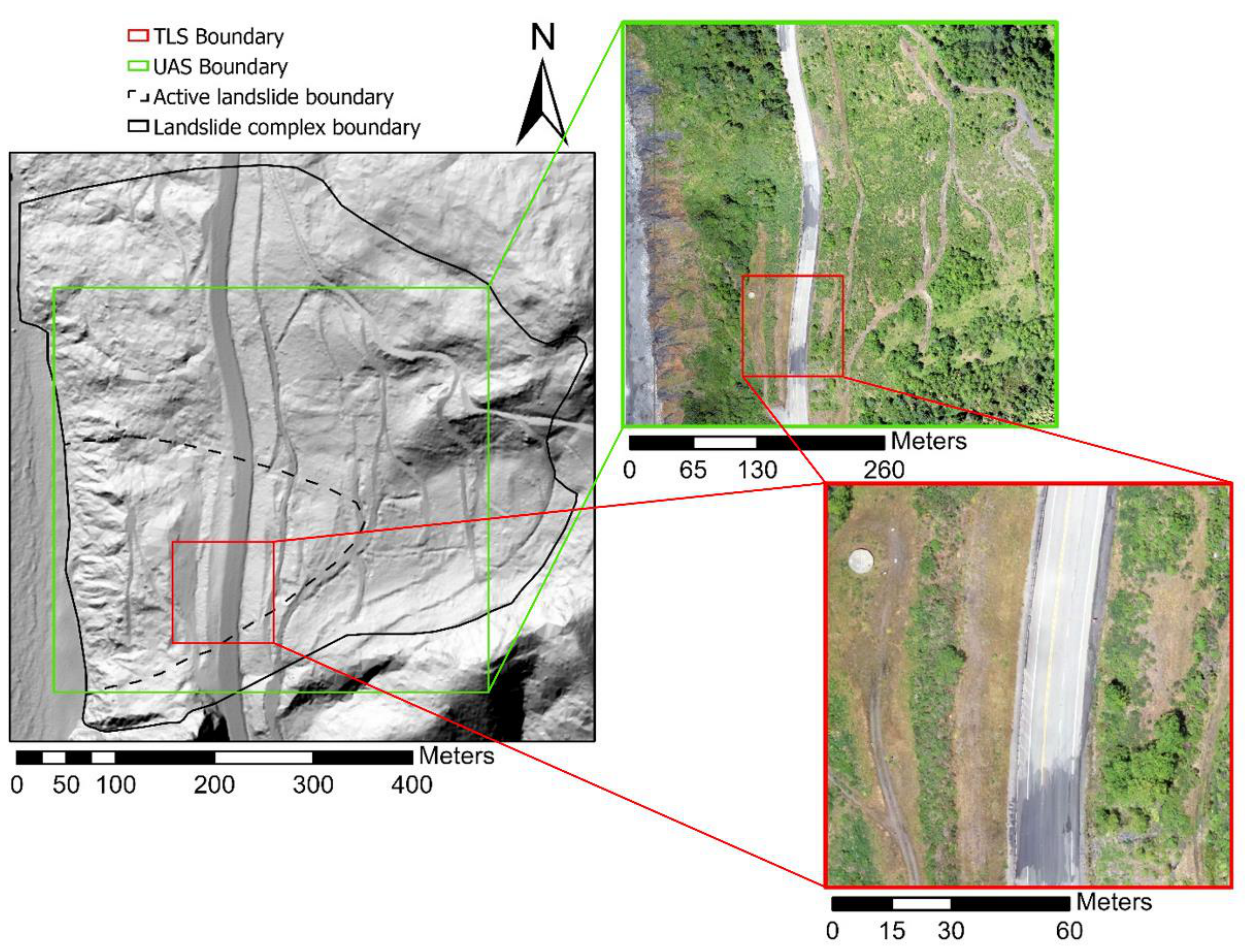
Figure 2. Overview map showing the Arizona Inn landslide complex and approximate boundaries, the section used for the quantitative analysis (TLS boundary), and the UAS data boundary.